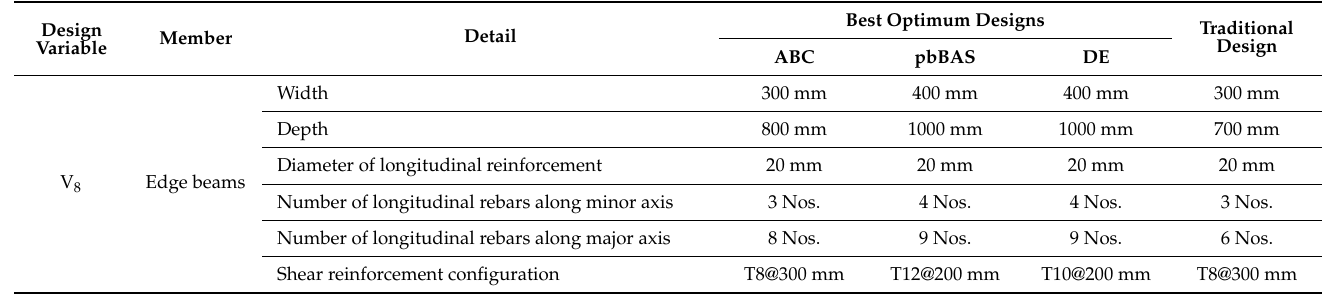
Table 25. The best optimum values of auxiliary members variables obtained by each metaheuristic algorithm for the three-segment type folded plate roof